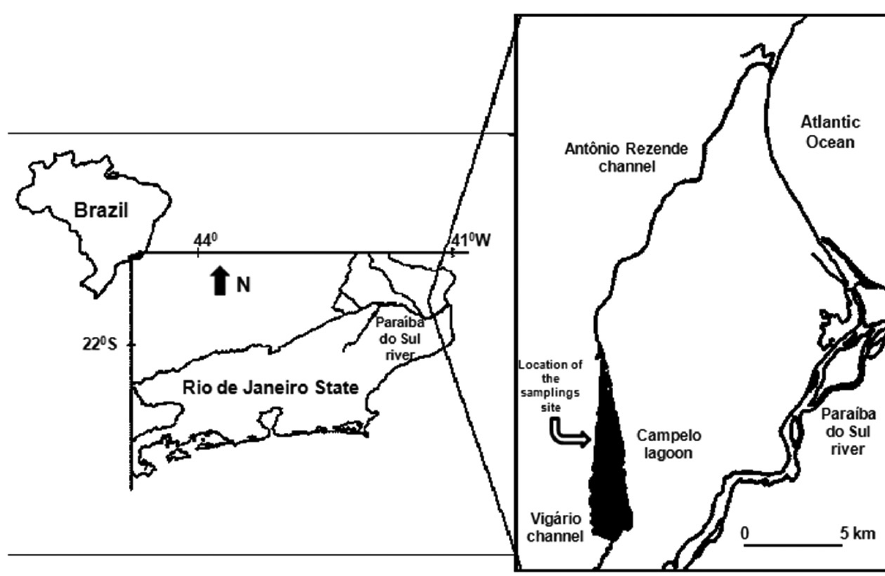
Figure 1. Study area and location of the sampling site in the Campelo